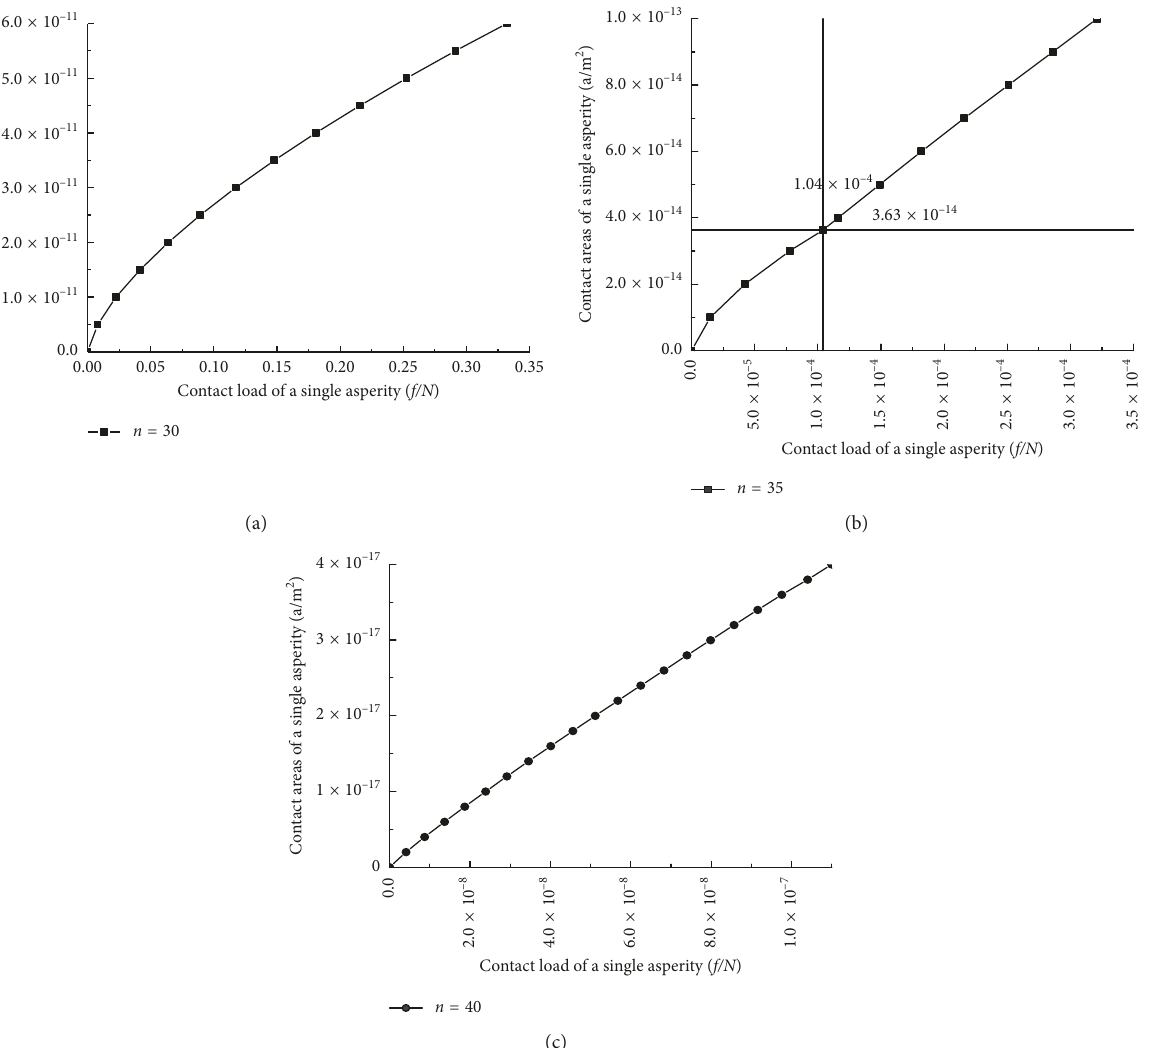
Figure 8: The relationship between contact load and contact area of a single asperity during